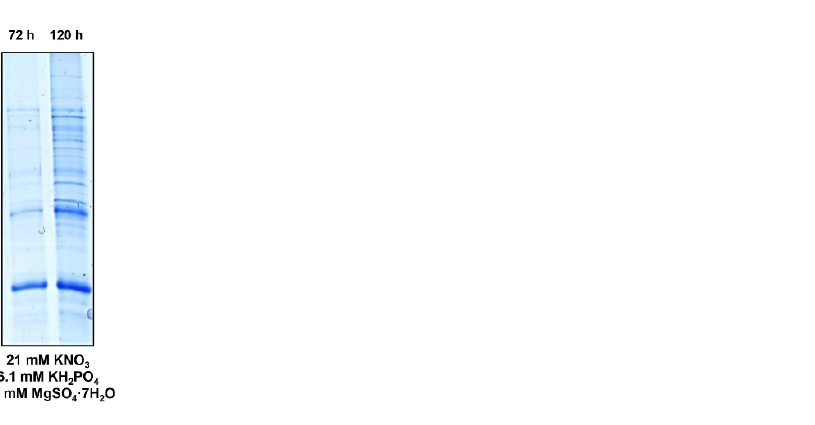
Figure 2. SDS-PAGE analysis of salt-stress-responsive fluid proteins extracted from ginseng cultured solution.